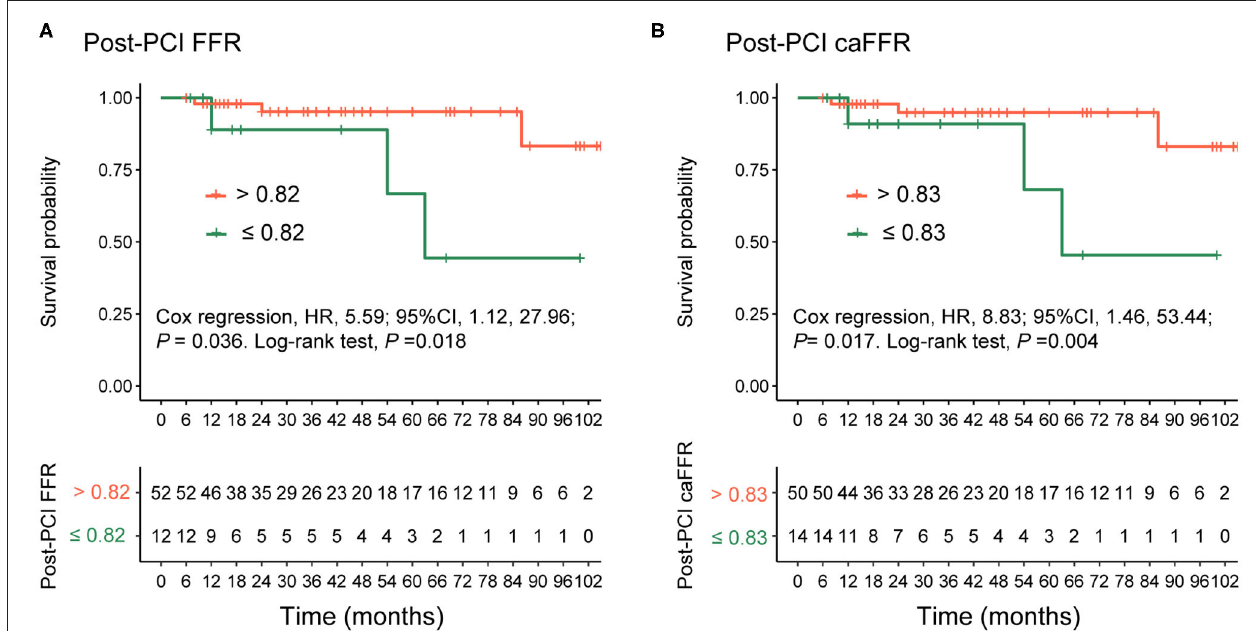
FIGURE 7 | Comparison of VOCEs according to post-PCI FFR or caFFR values. Kaplan–Meier curves showing that (A) patients with post-PCI wire-based FFR values > 0.82 had a higher survival free of VOCE compared with patients with post-PCI wire-based FFR values ≤ 0.82. (B) Patients with post-PCI caFFR values > 0.83 had a higher survival free of VOCE compared with patients with post-PCI caFFR values ≤ 0.83 group. VOCE, vessel-oriented composite endpoint; LAD, left descending artery; FFR, fractional flow reserve; PCI, percutaneous coronary intervention; caFFR, coronary angiography-derived